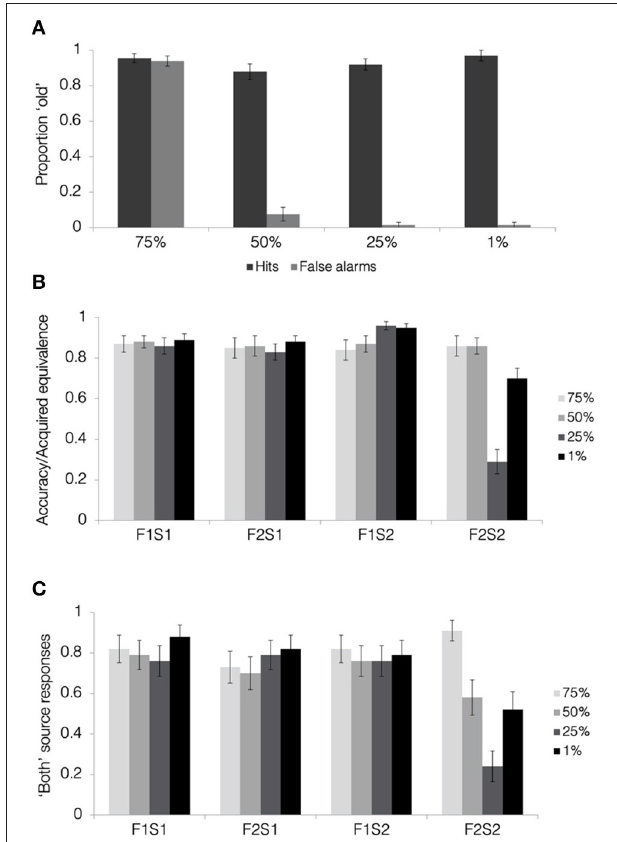
FIGURE 7 | Results from face recognition, acquired equivalence, and source memory tests in Experiment 3. (A) Hit and false alarm rates from the face recognition test. (B) Acquired equivalence test accuracy for trained associations (F1S1, F2S1, and F1S2) and rates of acquired equivalence for untrained associations (F2S2). (C) For the source memory test, the proportion of trials where the participants responded that they had seen the items together during both study and test. This was the correct response for the trained associations but constituted a false memory for the untrained associations, since they were presented only during the test. All results are depicted separately for pair-mates at each blend level. Error bars represent the standard error of the mean across